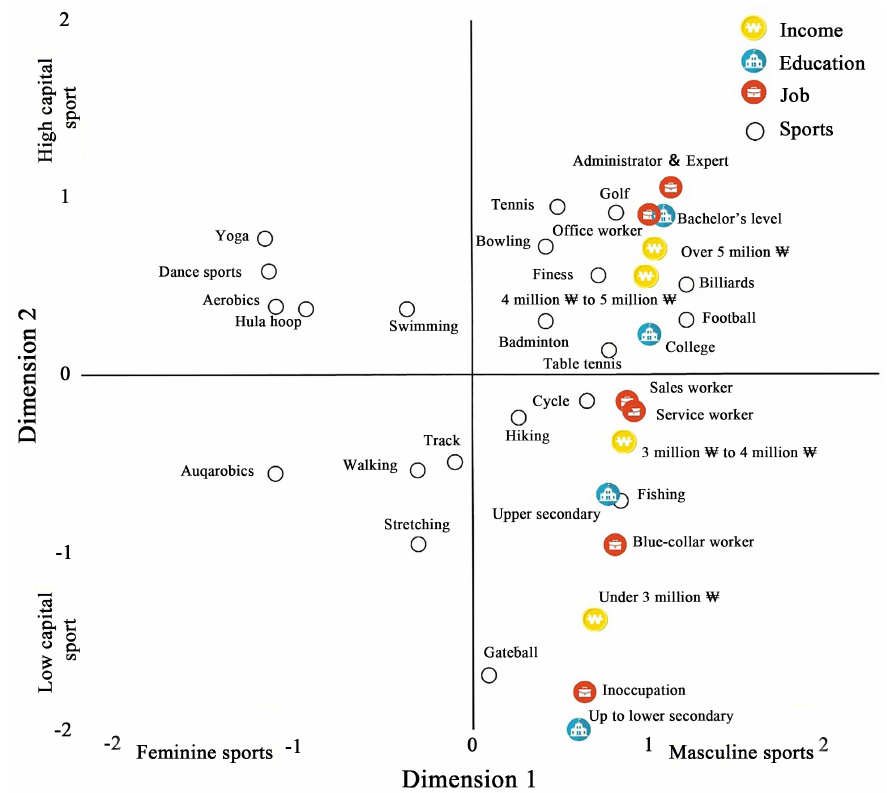
Fig. 1. Results of MCA for types of sports participation according to male social stratification.